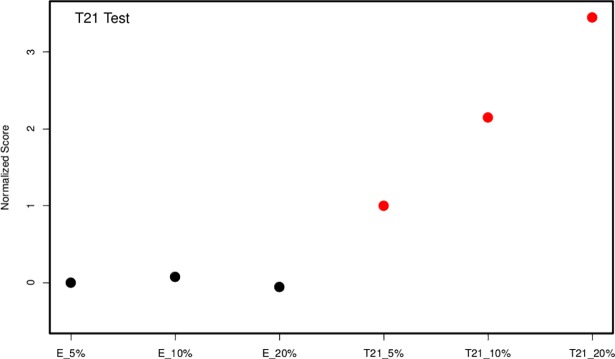
Detection of trisomy 21 in spiked-in samples.Euploid (black dots) and trisomy 21 (red dots) spiked-in samples simulating 5%, 10% and 20% fetal fractions were subjected to MeDIP combined with in-solution targeted enrichment followed by NGS. Z-score values of all trisomy 21 spiked-in samples were higher than the respective z-score values of euploid spiked-in samples and also demonstrated an increasing trend with respect to the fetal fraction. E, euploid; T21, Trisomy 21.